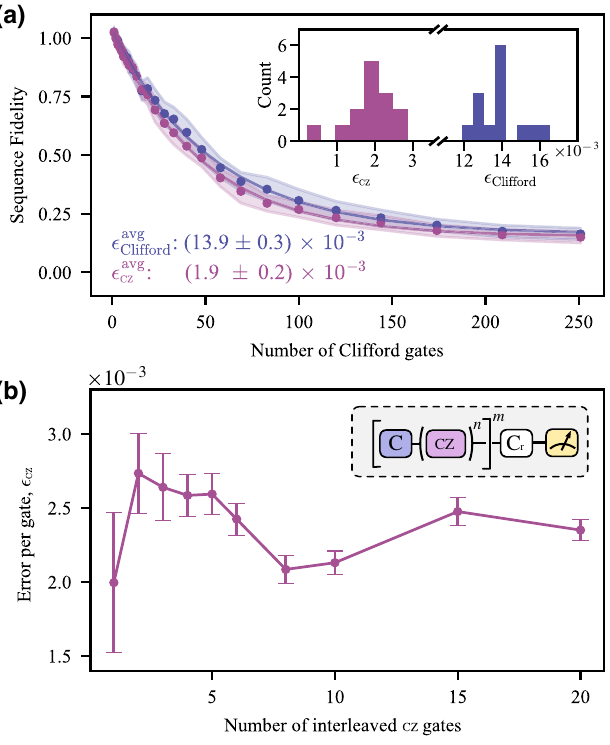
FIG. 3. The interleaved randomized benchmarking experi- ment for two qubits. (a) The experimental data of the sequence fidelity for randomized benchmarking with interleaved CZ gates (purple dots) and the reference Clifford sequence (blue dots) as a function of the number of Clifford gates. The purple and blue shaded regions indicate the standard deviation of 30 ran- dom sequences for the interleaved randomized benchmarking experiment and the reference Clifford sequence, respectively. The histograms in the inset show the error per Clifford gate (blue) and the error per CZ gate (purple) for the 14 repeated experiments, from which the average error per Clifford gate = ( 1.39 ± 0.03 ) × 10 − 2 and the average error per CZ of (cid:8) avg Clifford = ( 1.9 ± 0.2 ) × 10 − 3 are estimated. (b) The exper- gate of (cid:8) avg CZ imentally obtained error per CZ gate as a function of the num- ber of interleaved CZ gates n in the randomized benchmarking sequence. The error bars indicate the standard deviation extracted from the residuals of the best model fit of the sequence decay for n interleaved CZ gates. The gate sequence is depicted in the inset: a random Clifford gate C followed by n CZ gates, repeated m times, after which a reversing Clifford gate C r is applied. Extrac- tion of the fitting error for the sequence fidelity for n interleaved CZ gates yields a reduction in the uncertainty of the error per CZ gate by a factor of 1 / n